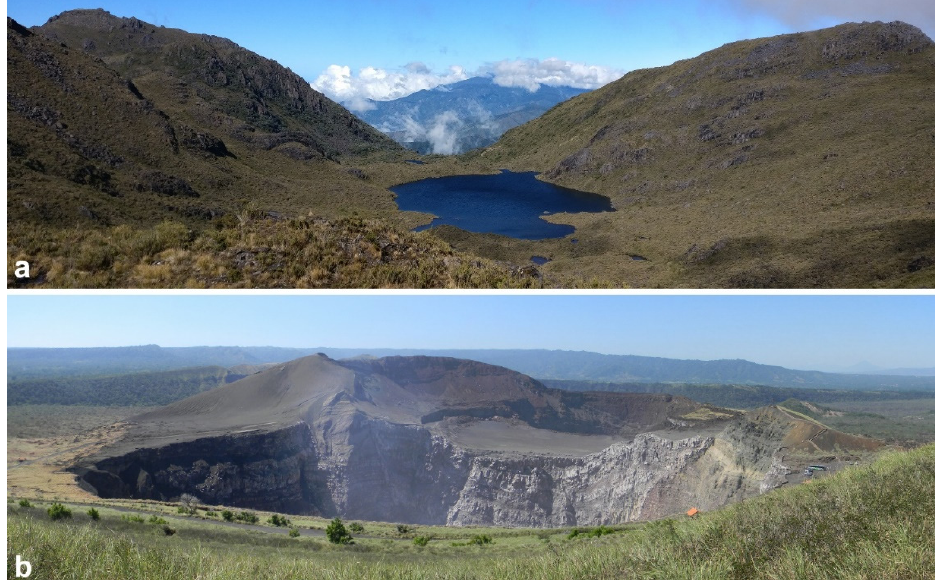
Figure 6. ( a ) Glacial landscapes in Chirripó National Park in Costa Rica. ( b ) Masaya volcano in Nicaragua. Photos: Adolfo Quesada-Román.